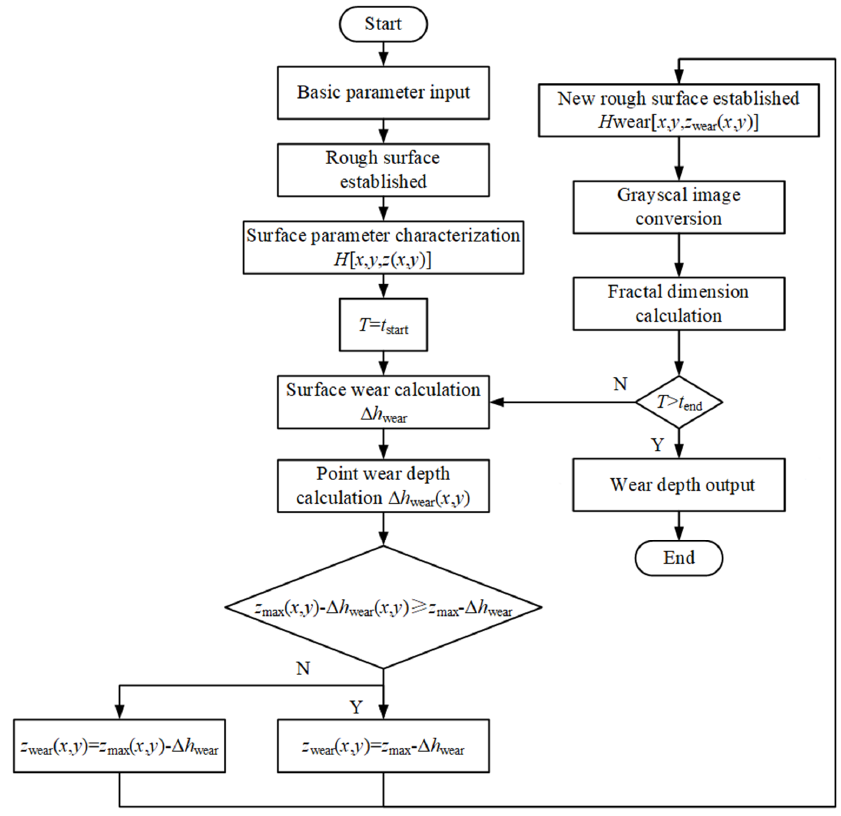
Figure 7. Flow chart of iterative calculation of wear cycle.